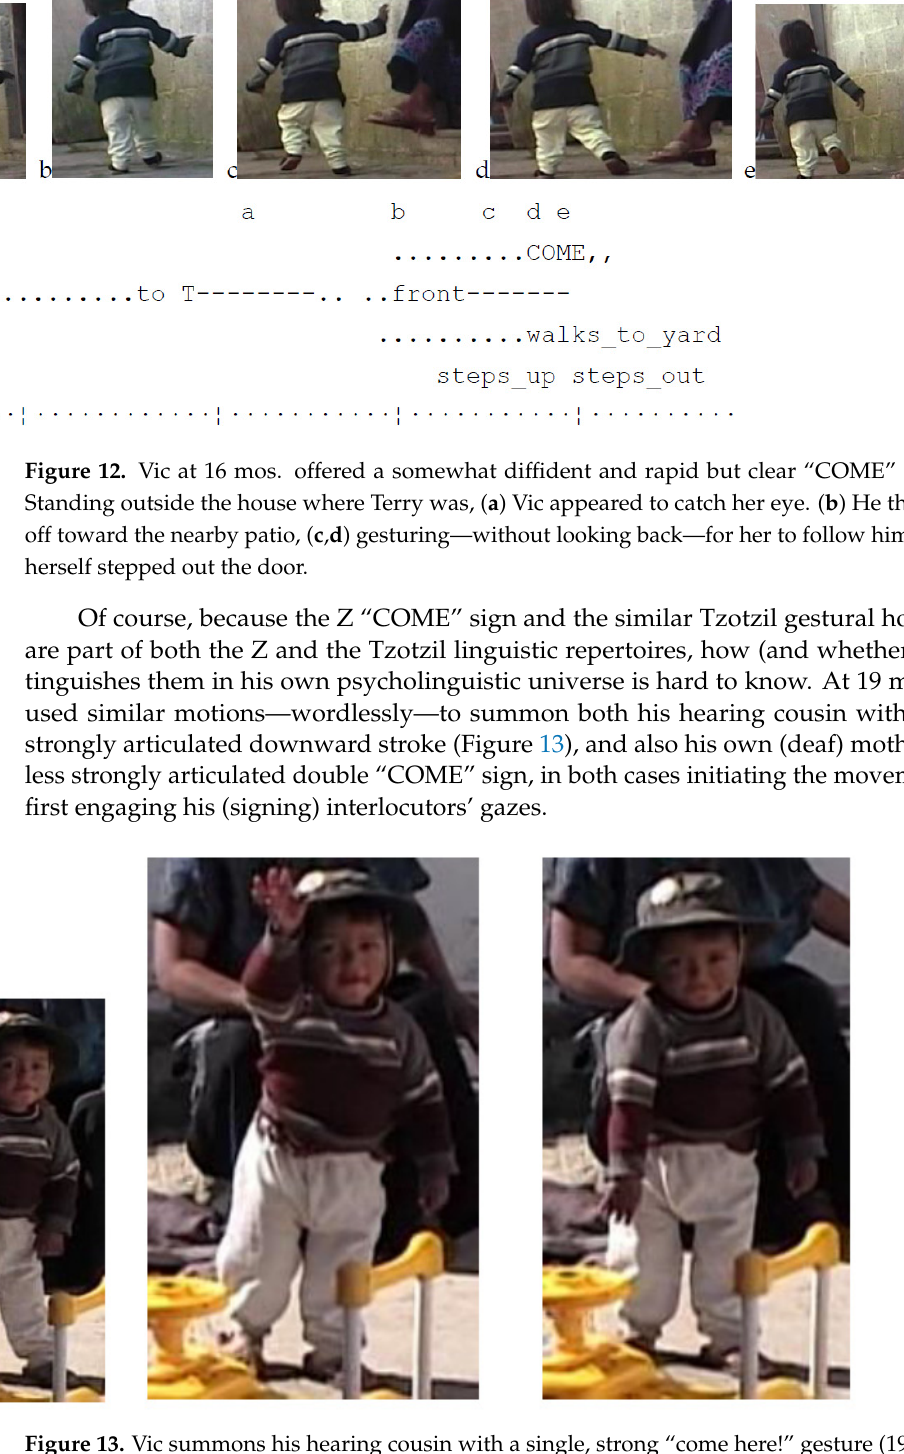
Figure 13. Vic summons his hearing cousin with a single, strong “come here!” gesture (19 moss).